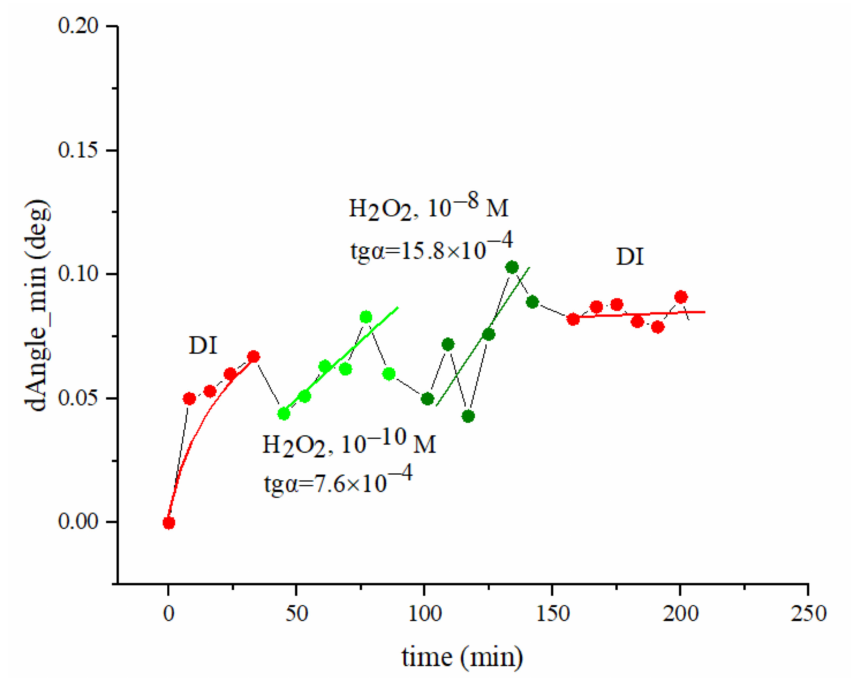
Figure 4. Shift in the resonance minima during the interaction of hydrogen peroxide solutions with concentrations of 10 − 10 M and 10 − 8 M with the Au/Ag